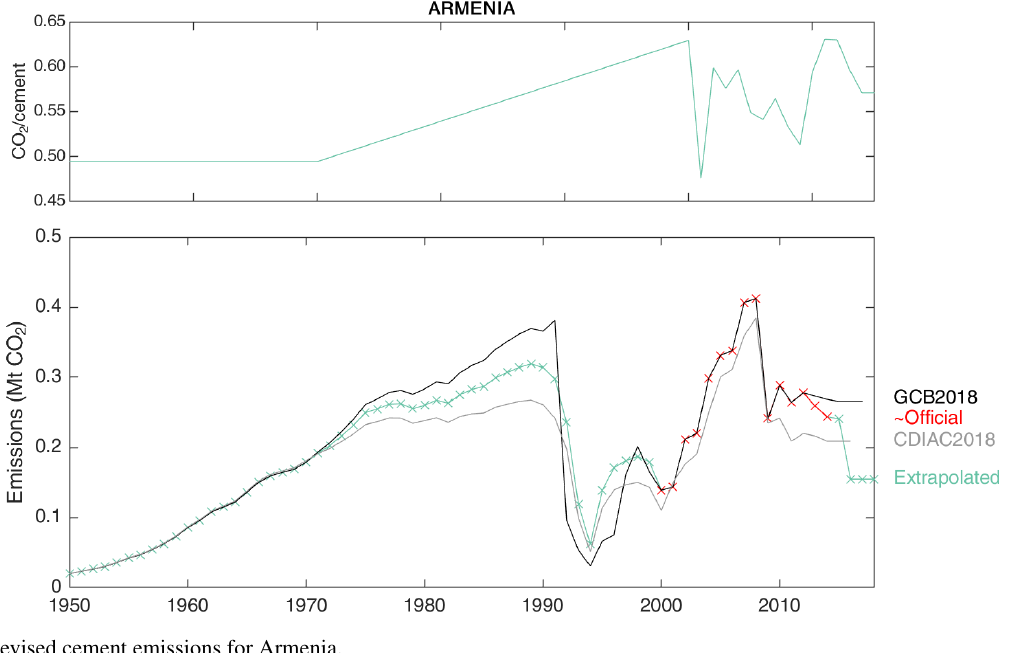
Figure C9. Revised cement emissions for Armenia.